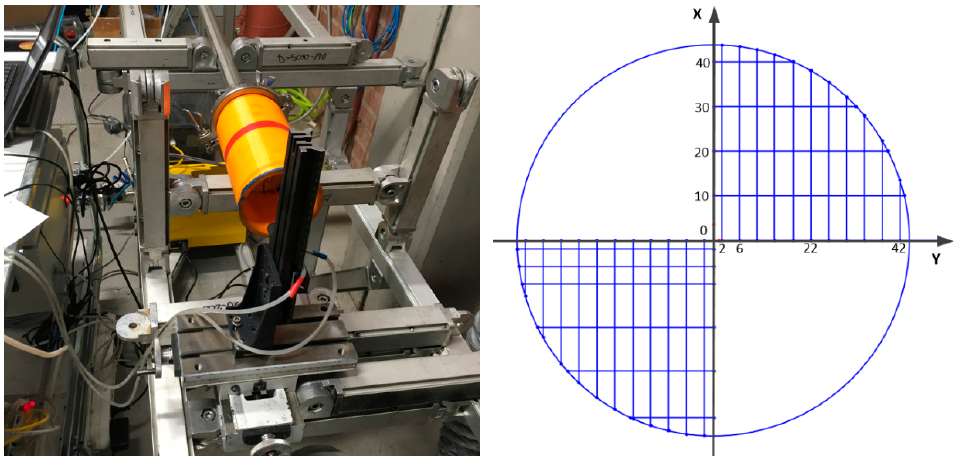
Figure 6. Prandtl sampling setup and sampling position schematic (right).